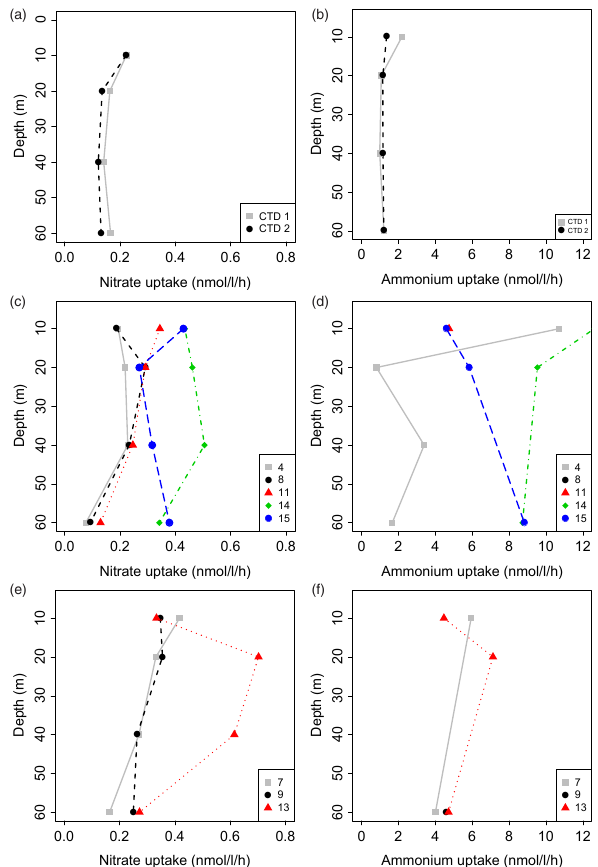
Figure 3. Nitrate and ammonium uptake rates profiles for the sum- mer cruise; (a) , (c) and (e) show the nitrate uptake profiles for the polar frontal zone stations, process station A and B; (b) , (d) and (f) show the ammonium uptake profiles for the polar frontal zone sta- tions, process station A and B. The numbers in the legend represent the CTD (conductivity–temperature–depth)